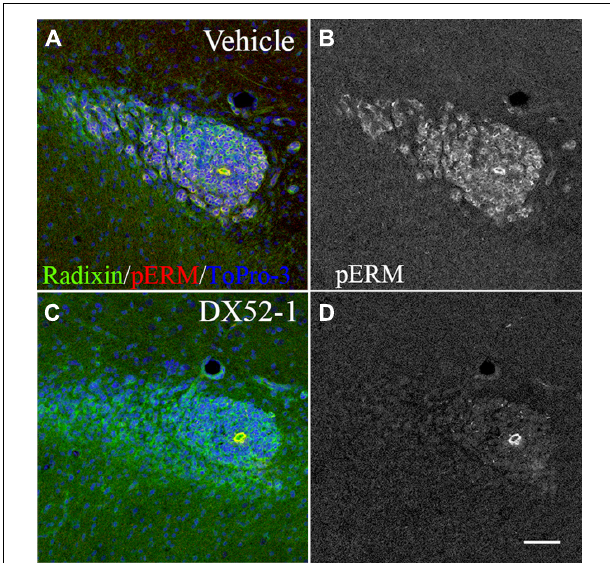
FIGURE 5 | Decreased phosphorylation of radixin in the RMS after DX52-1 treatment. (A) Merged image of radixin and phosphorylated rzrin/radixin/moesin (pERM) immunoreactivity in a coronal section of the control RMS. (B) pERM immunoreactivity in the control RMS. (C) Merged image of radixin and phosphorylated ezrin/radixin/moesin (pERM) immunoreactivity in a coronal section in the DX52-1 treated RMS. (D) pERMimmunoreactivity in the DX52-1 treated RMS. Radixin/pERM immunopositive circular structures in B and D are likely residual ependymal cells originating from the wall of the collapsed olfactory ventricle (Peretto etal., 1997). Ependymal cells are known to express high levels of ezrin which explains sustained pERM expression in this area in both control and DX52-1 treated RMS. Scale bar = 50 μ m.